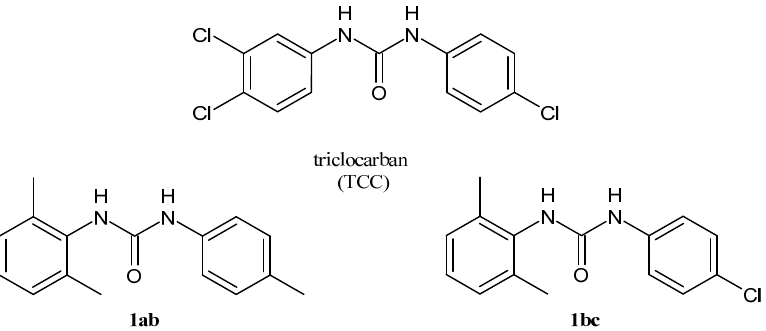
Figure 1. Triclocarban (TCC), and active compounds 1ab and 1bc .